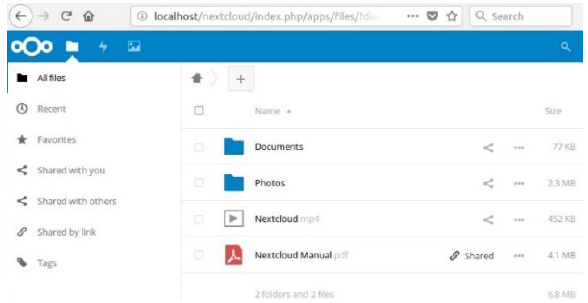
Figure 6. File - directory structure of the Cloud